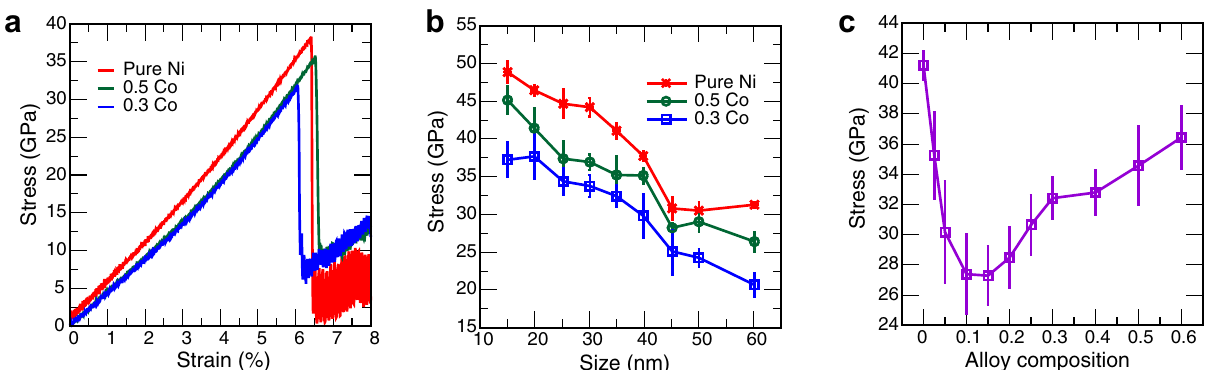
Fig. 5 Mechanical properties of nanoparticles. a Typical engineering stress-strain curves for a 40 nm particle. b Strength as a function of particle size. c Strength as a function of chemical composition for 35 nm particles. The error bars represent one standard deviation.